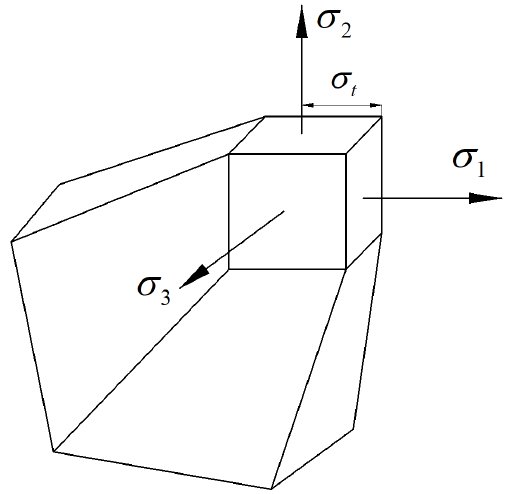
Figure 2. Mohr–Coulomb with Rankine tensile yield surface.